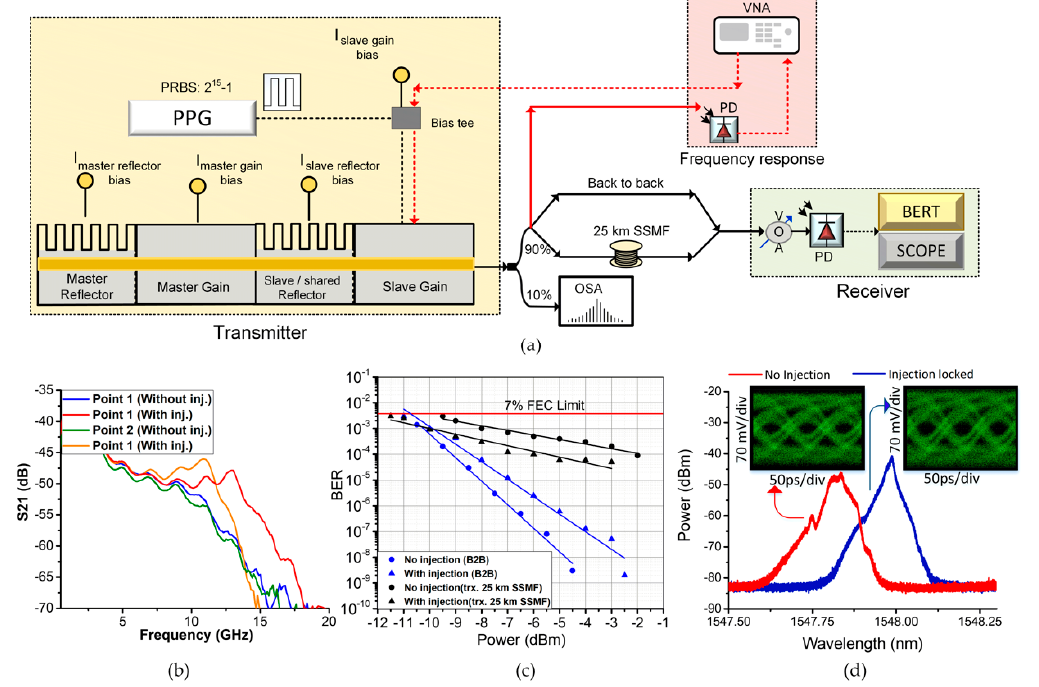
Figure 6. ( a ) Schematic setup diagram of frequency response measurements (red wire connections), short-reach transmission system (black wire connections); solid lines: optical connections, dashed lines: electrical connections; ( b ) frequency response of the slave laser two bias points of the PIC listed in Table 5 without (blue, green) and with (red, orange) injection; ( c ) BER results for back to back (B2B) (blue) and 25 km SSMF transmission distances (black) with and without injection; ( d ) optical spectra of the PIC under modulation with injection (blue) and without injection (red); inset: obtained eye diagrams after 25 km SSMF transmission and 0.5 dBm received optical